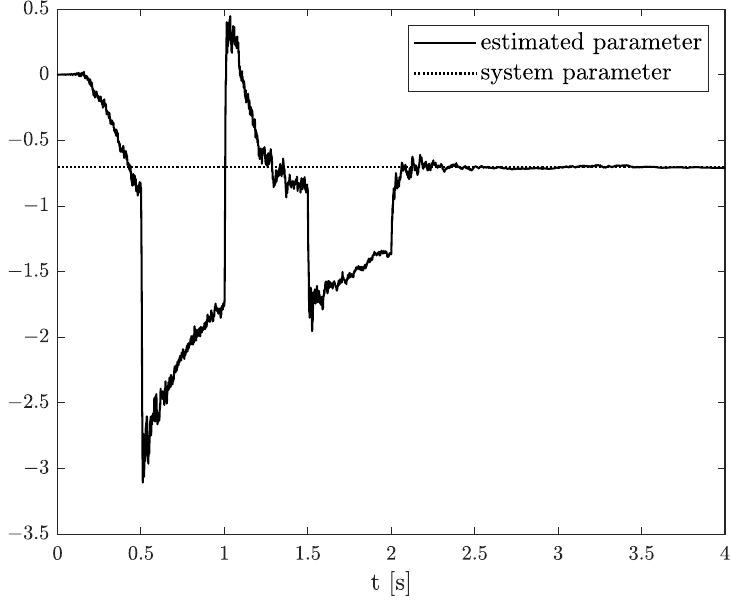
Figure 7. Original and estimated parameters from Example